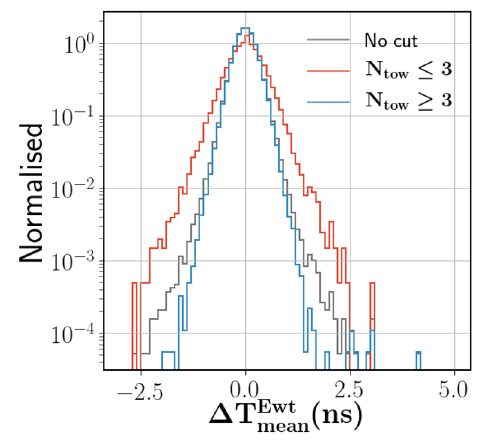
) without and with cuts on the number of Figure 7 . Energy-weighted mean timing of a jet (∆ T Ewt mean ECAL towers, N 3 and N 3 , for jets from the QCD dijet events ( p gen ∈ { 30 , 50 } tow ≤ tow ≥ T